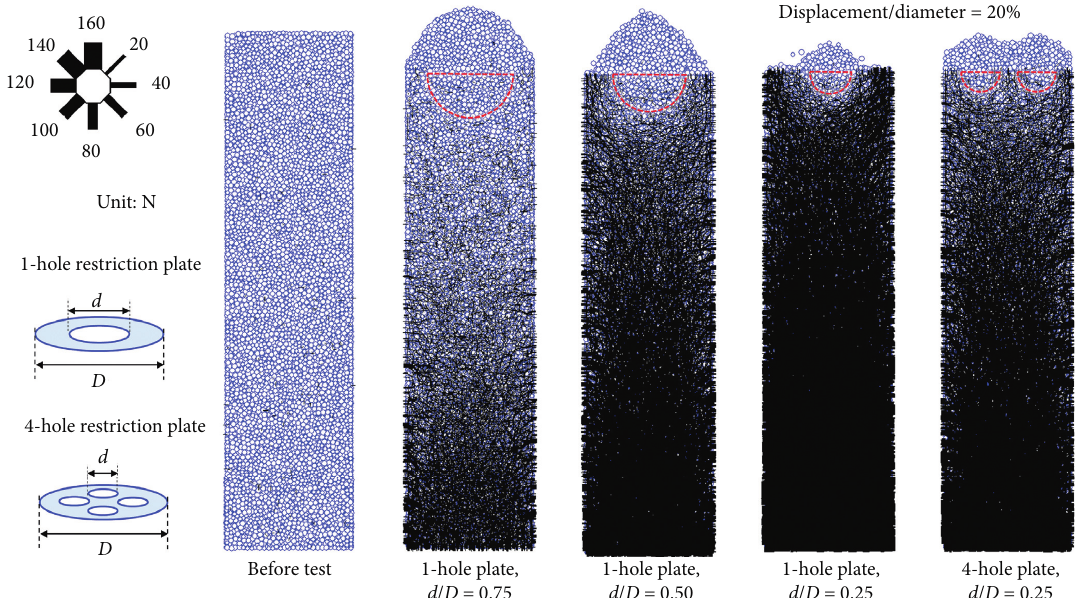
Figure 13: Particle contact force transmission inside soil plugs with different types of restriction plates ( D � 10cm and L / D � 4.0).